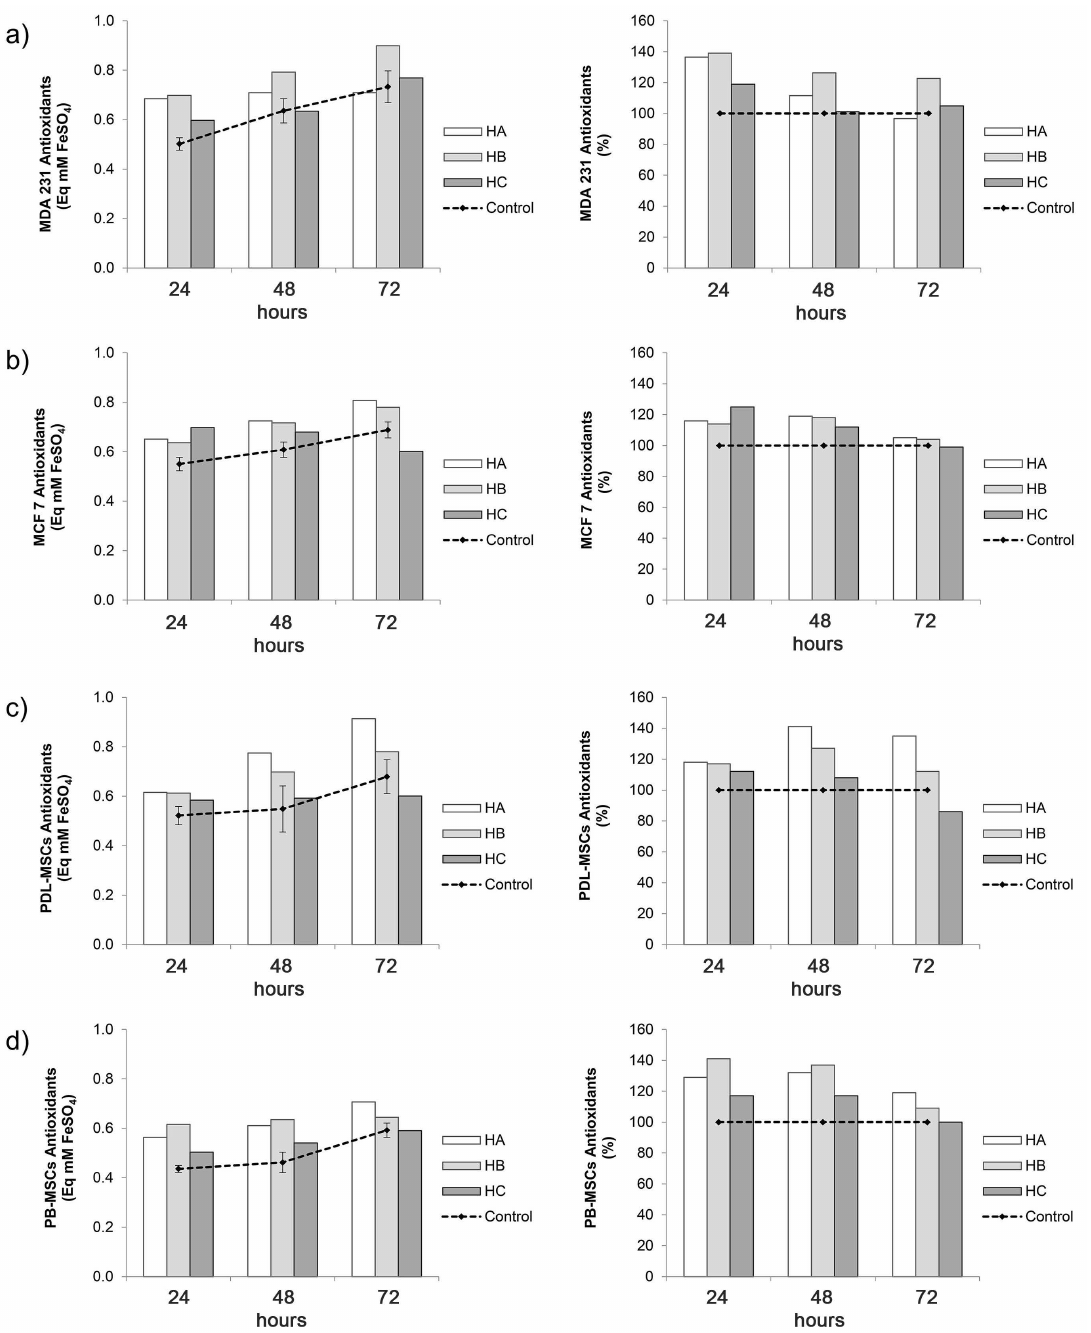
Figure 8. Hennosides at a concentration of 100 µ g/mL enhance the concentration of antioxidants in supernatants of human breast cancer cells MDA 231 ( a ) and MCF-7 ( b ), and primary human periodontal ligament and peripheral blood mesenchymal stem cells, PDL-MSC ( c ) and PB-MCS ( d ) in short-term cell culture. The result of FRAP assay is given as the concentration of antioxidants presented as mM equivalent to FeSO4 concentration (mM), and as a percentage of corresponding control. Control (set at 100%) is the concentration of antioxidants in supernatants of cells grown without